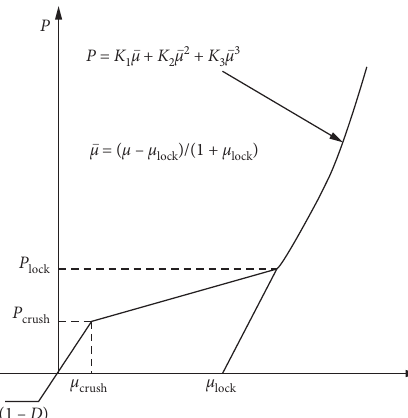
Figure 5: Relationship of hydrostatic pressure and volumetric strain in JHC